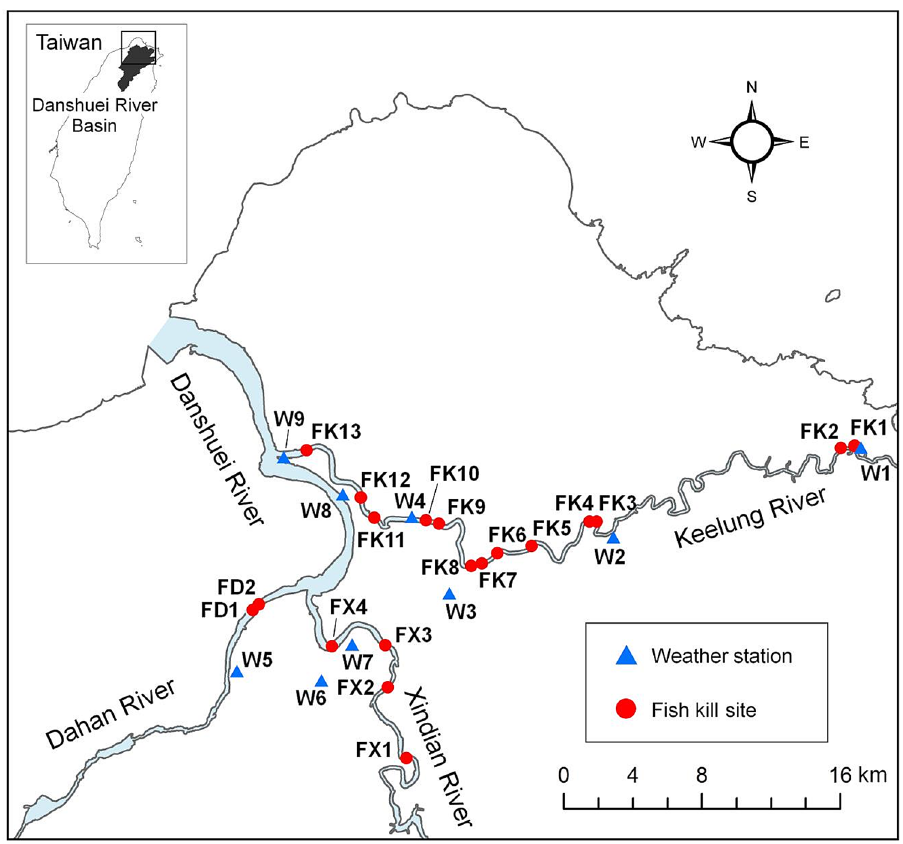
Figure 1. The fish kills occurred in the downstream of each tributary of the Danshuei River (red dots in the figure), and we gathered meteorological data from the nearby weather stations (blue triangles in the figure). This map was generated using ArcGIS version